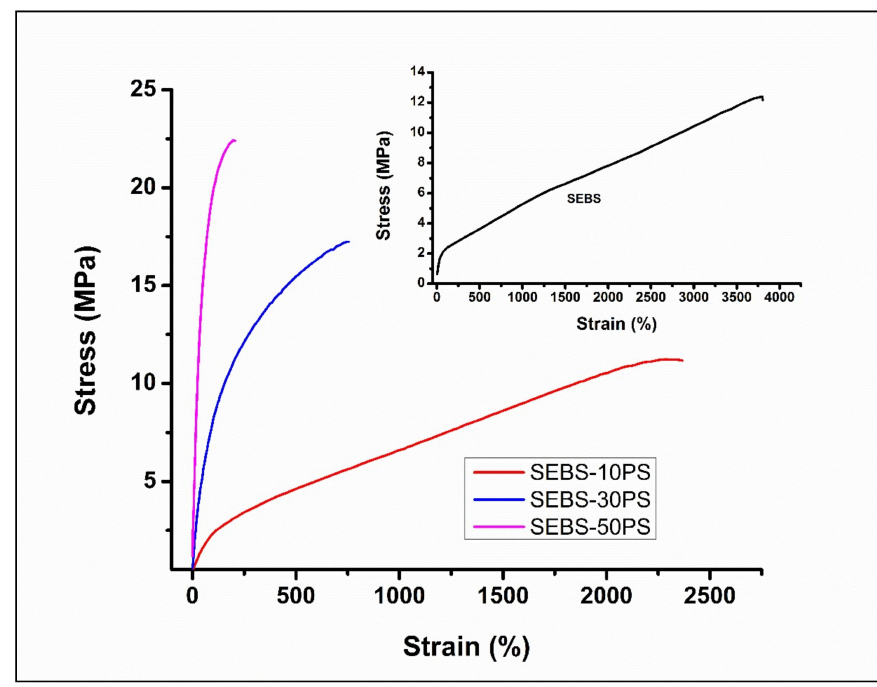
Figure 5. Representative tensile curves of SEBS and the